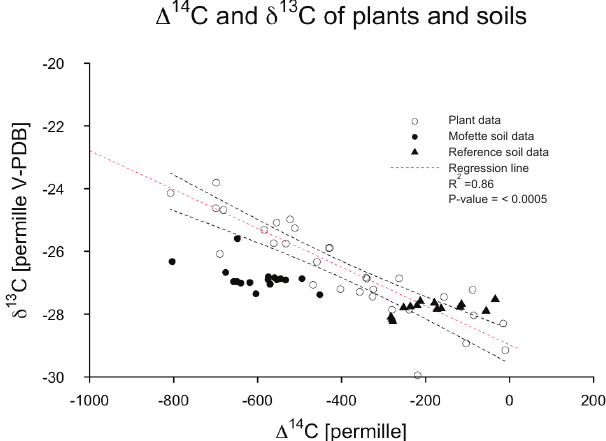
Figure 1. Correlation between δ 13 C and (cid:49) 14 C of plants growing around the mofette structure. Dependent on exposure plants incor- porate different amounts of geogenic CO 2 , which complicates iso- tope mass-balance calculations for mofette SOM. However, both isotopes are highly correlated in sampled plant material, which al- lows for prediction of δ 13 C SOM isotope values from plant (cid:49) 14 C. Most data points measured from mofette SOM fall outside 95% confidence levels of the regression, which suggests a deviation of mofette SOM δ 13 C values from a pure vegetation signal. Reference SOM δ 13 C values fall mainly within the observed plant δ 13 C val- ues. Parameters of the regression are used to predict the δ 13 C SOM values expected in mofette soils that correspond to measured ra- diocarbon values, assuming that all carbon would be plant derived (Eq.